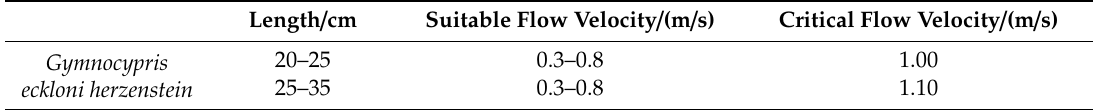
Table 1. Gymnocypris eckloni